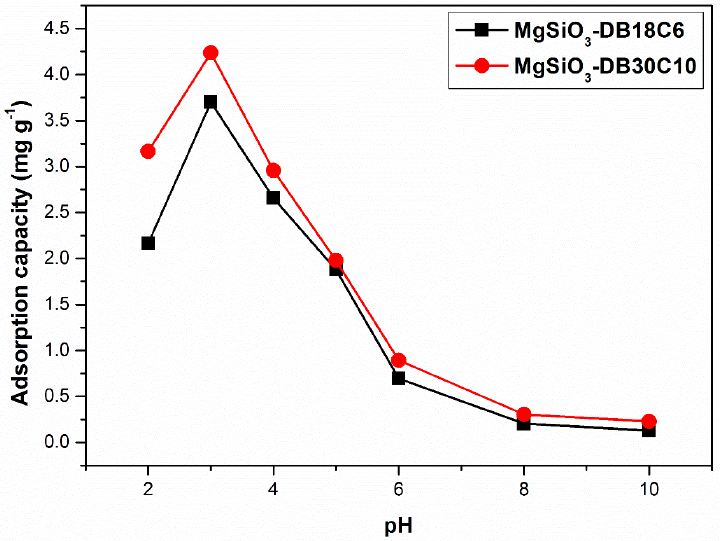
Figure 6. pH effect upon the adsorption capacity of the functionalized